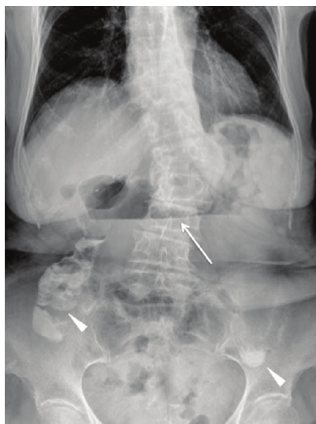
Figure 1: Plain abdominal radiography, performed at the time of emergency admission, shows the presence of a gastroduodenal air-fluid level (white arrow). The partial opacification of residual intestinal lumen (arrowheads) is due to assumption of oral contrast agent in a previous radiographic study performed one week before in another